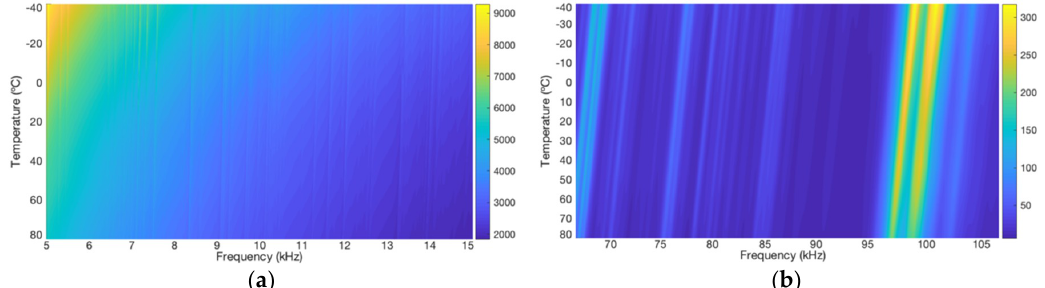
Figure 8. Trendlines of the horizontal shift of the impedance magnitude pipe-1/PZT-1: ( a ) at low frequency and ( b ) at high frequency. frequency and ( b ) at high frequency.